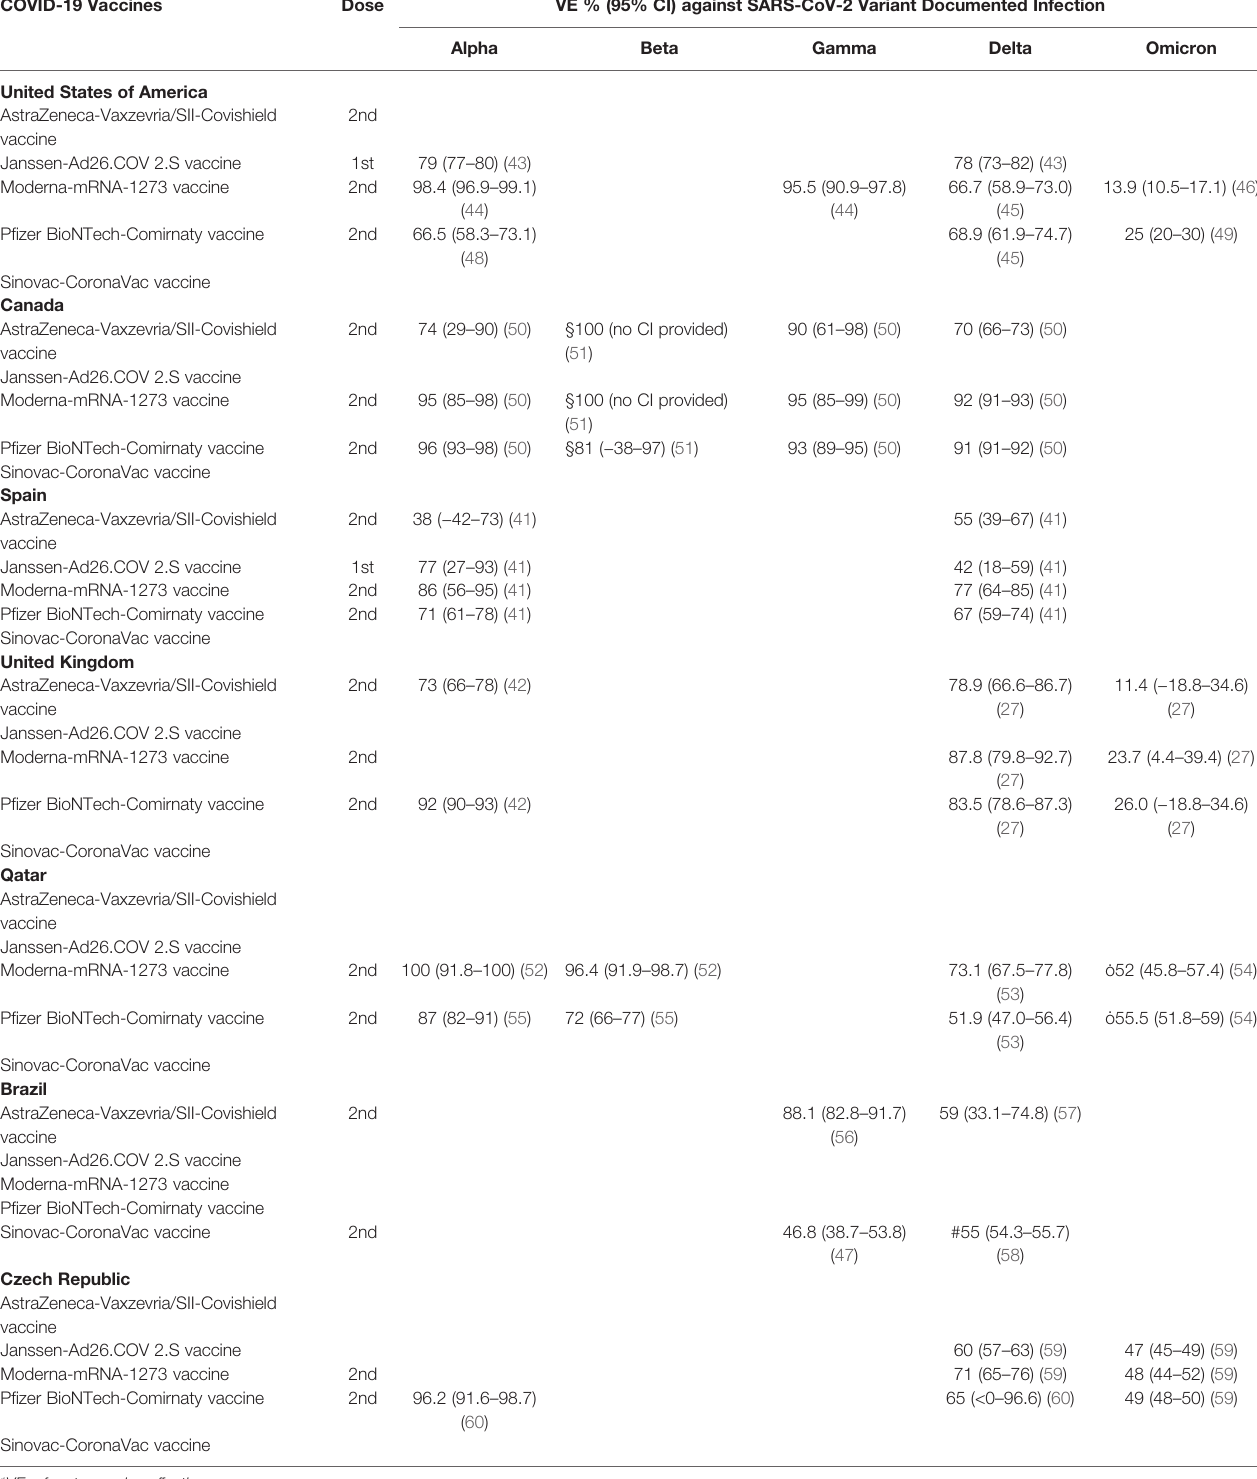
TABLE 3 | COVID-19 VE * against SARS-CoV-2 variant infection. COVID-19